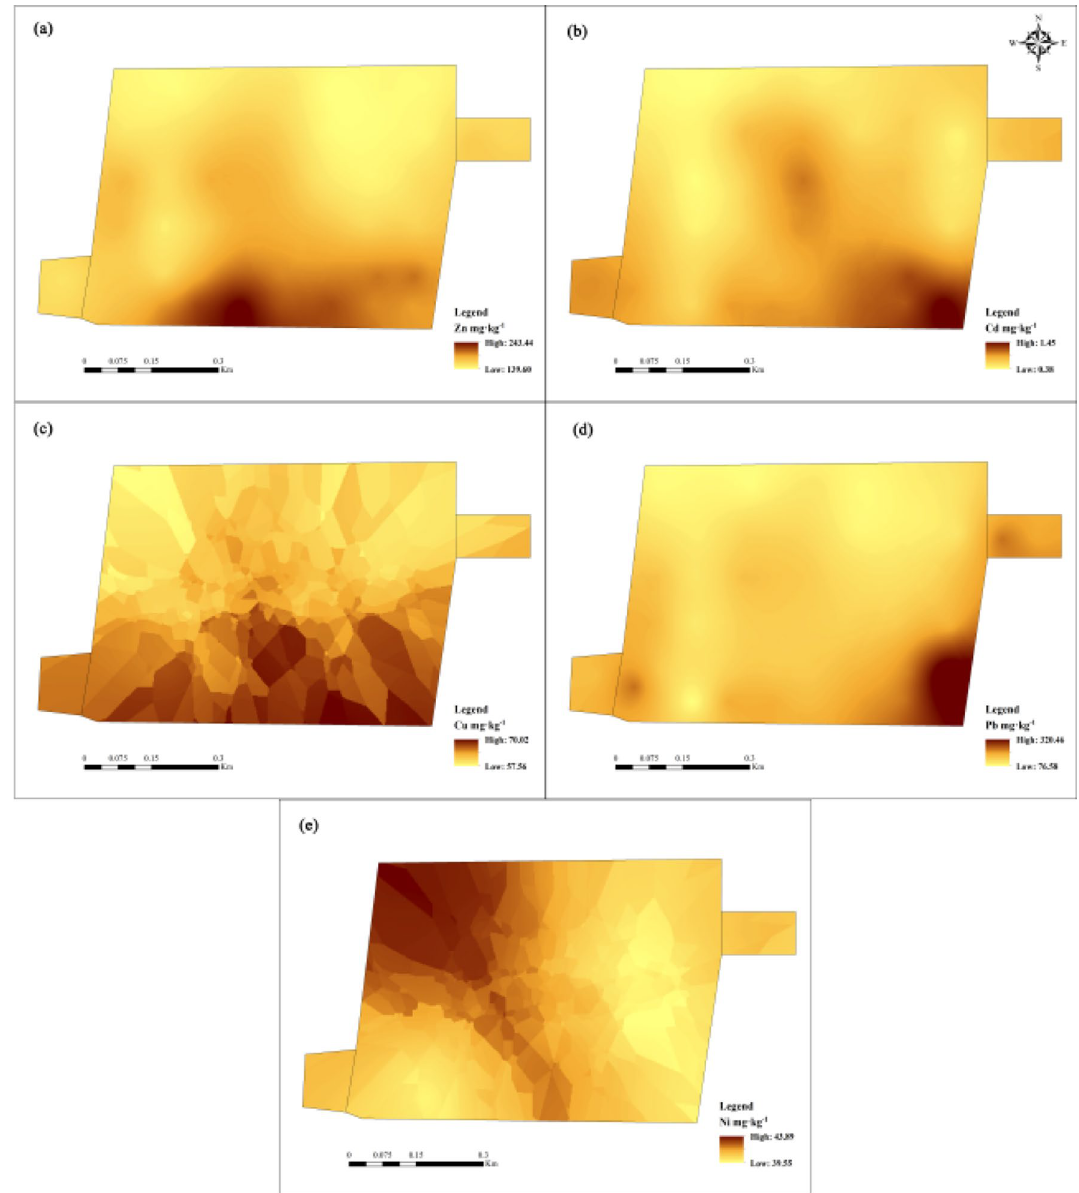
Figure 5. Spatial distribution of heavy metal elements in soil of the study area ( a ) Zn ( b ) Cd ( c ) Cu ( d ) Pb ( e )